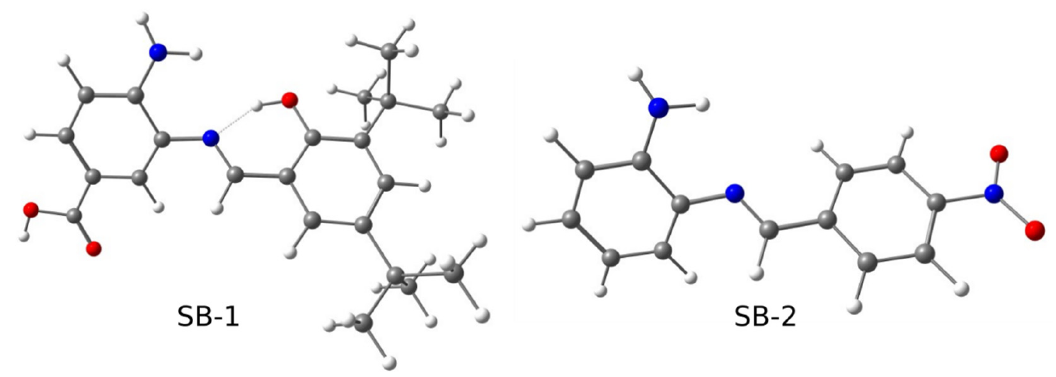
Figure 1. Geometry optimizations of SB-1 and SB-2. Blue: N; red: O; white: H; gray: C.